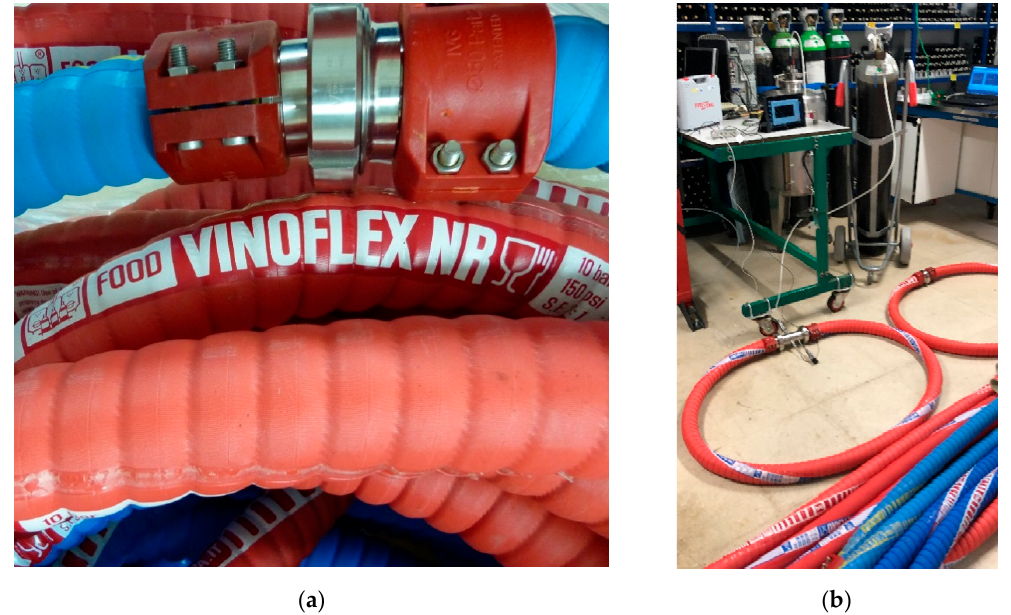
Figure 2. ( a ) Detail of the hoses with the connector DIN 11851; ( b ) View of the characterization ring of the hoses of different materials.